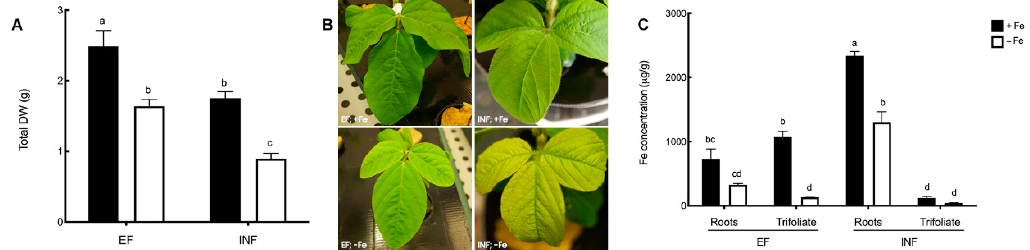
Figure 2. Morpho-physiological effects of Fe deficiency in efficient (EF) and inefficient (INF) soybean lines. ( A ) Total dry weight (DW); ( B ) chlorosis symptoms; ( C ) Fe concentration (µg/g) in roots and trifoliate leaves. Plants were grown under Fe su ffi ciency ( + Fe, 20 µ M) or Fe deficiency ( − Fe, no Fe)